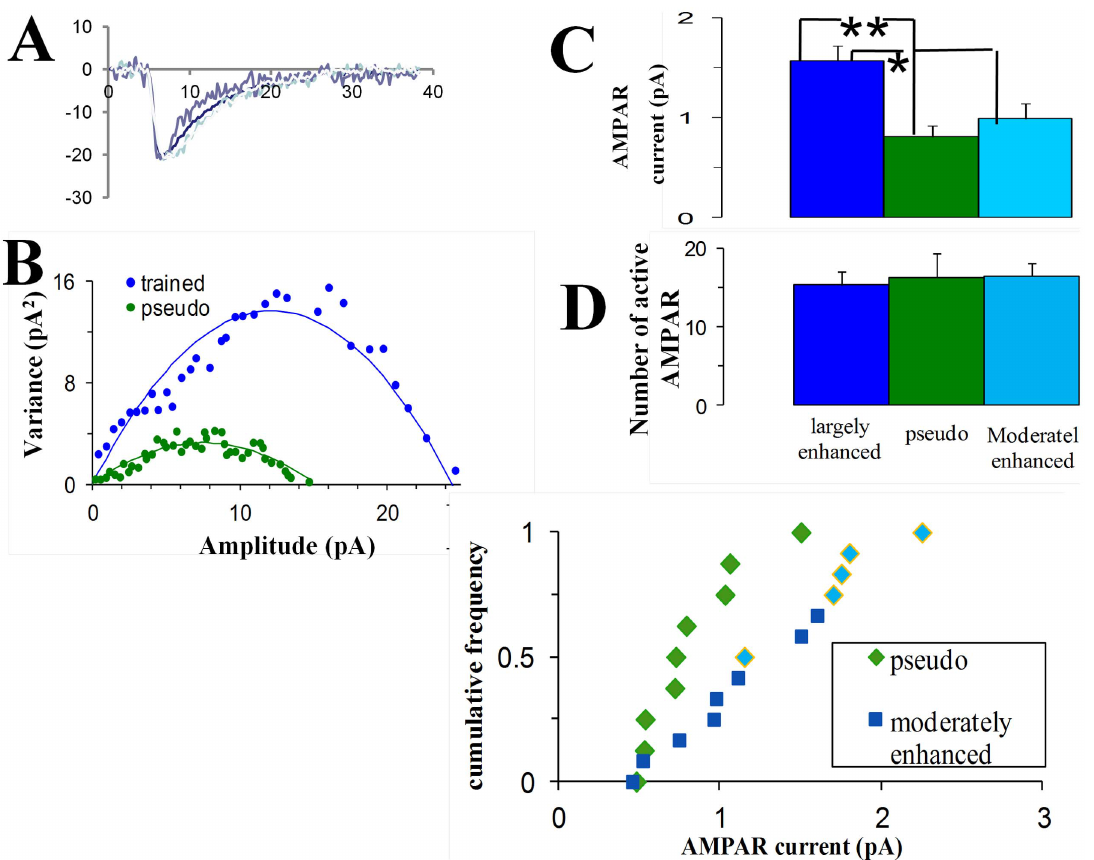
Figure 3. The average AMPAR-mediated conductance is doubled in the greatly-enhanced-trained-group. A, B. Events were peak scaled (A) and only events with rise-time , 1.5 ms were used for the NSFA analysis. Variance between these peak scaled events was calculated at different time points. Current-variance plot extracted from the peak scaled mEPSC’s using the NSFA analysis could be well fitted with the parabolic current-variance equation (see Methods), allowing the extraction of the averaged single channel conductance and averaged number of active AMPA channels. Examples from a pseudo-trained cell (green) and from a cell in the greatly-enhanced-trained-group (blue) are shown (B). C. The averaged AMPA single channel conductance in the greatly-enhanced-trained-group was doubled compared with the pseudo-trained group, and is 59% bigger than in the moderately-enhanced-trained group. Values represent mean 6 SE, (**, p , 0.01. *, p , 0.05). D. The number of active AMPA channels does not differ between groups. E. The greatly enhanced group shows distinct values of averaged AMPAR conductance as compared with the moderately enhanced group.